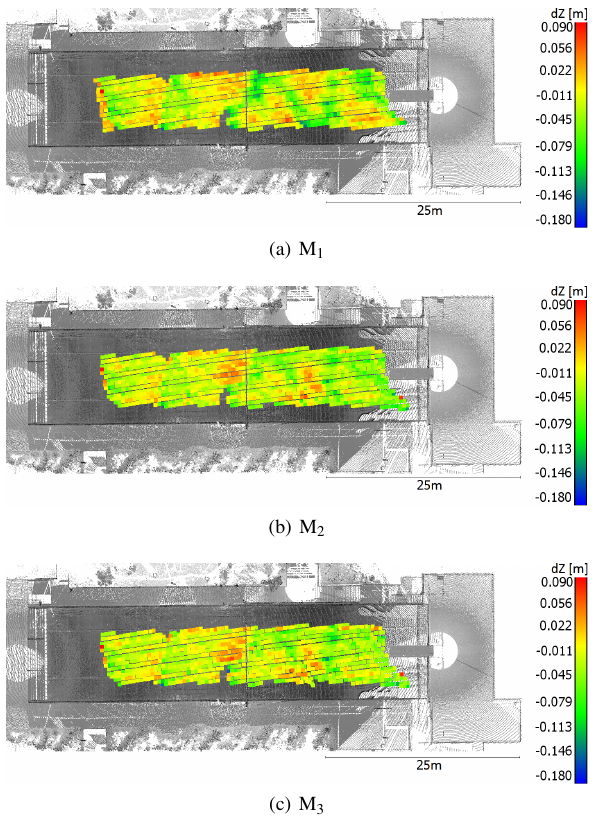
Figure 7. Deviation dZ between refraction corrected ALS point clouds (colored) and TLS point cloud (grey) at the pool bottom.